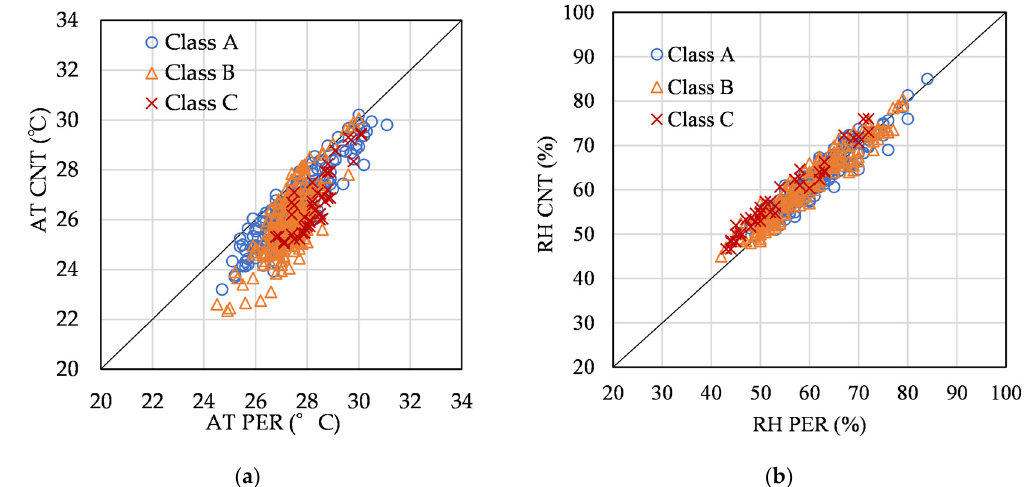
Figure 17. PER and INT correlation for ( a ) air temperature and ( b ) relative humidity.